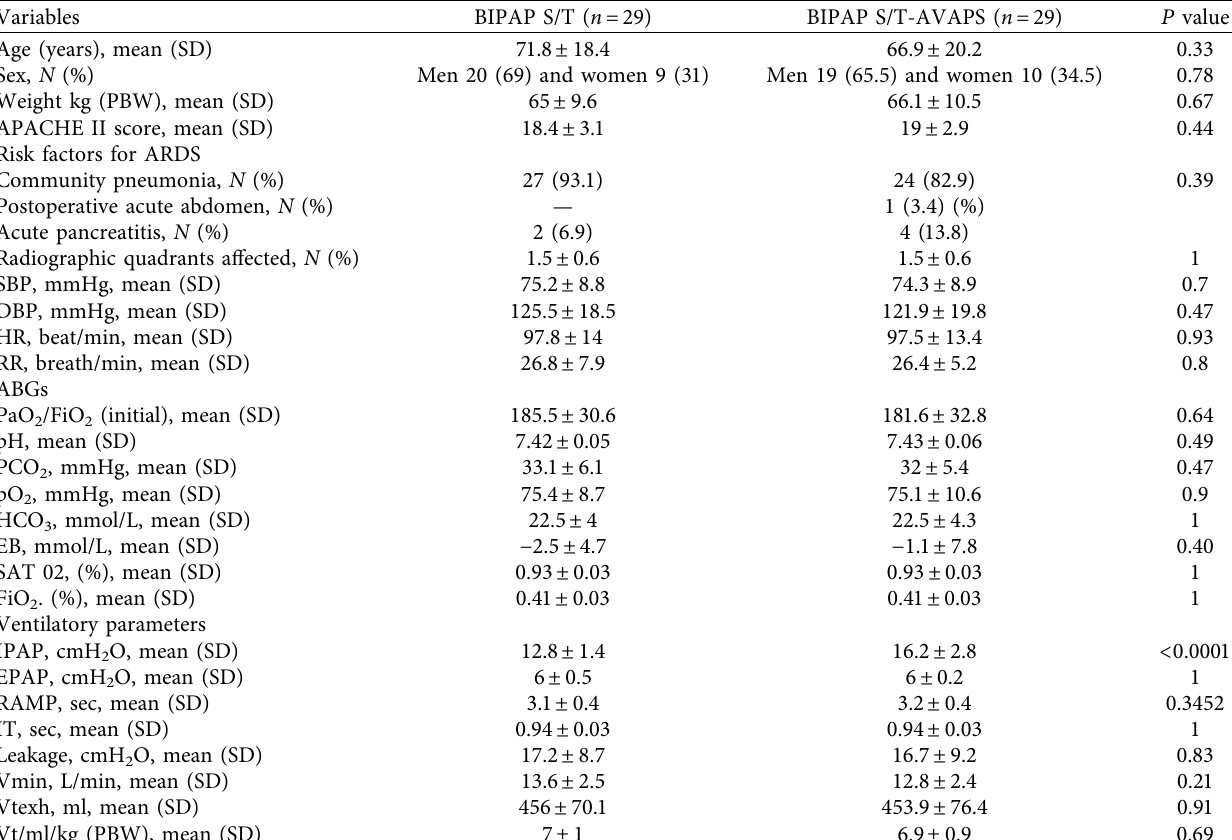
Table 2: Comparison of characteristics between the groups.